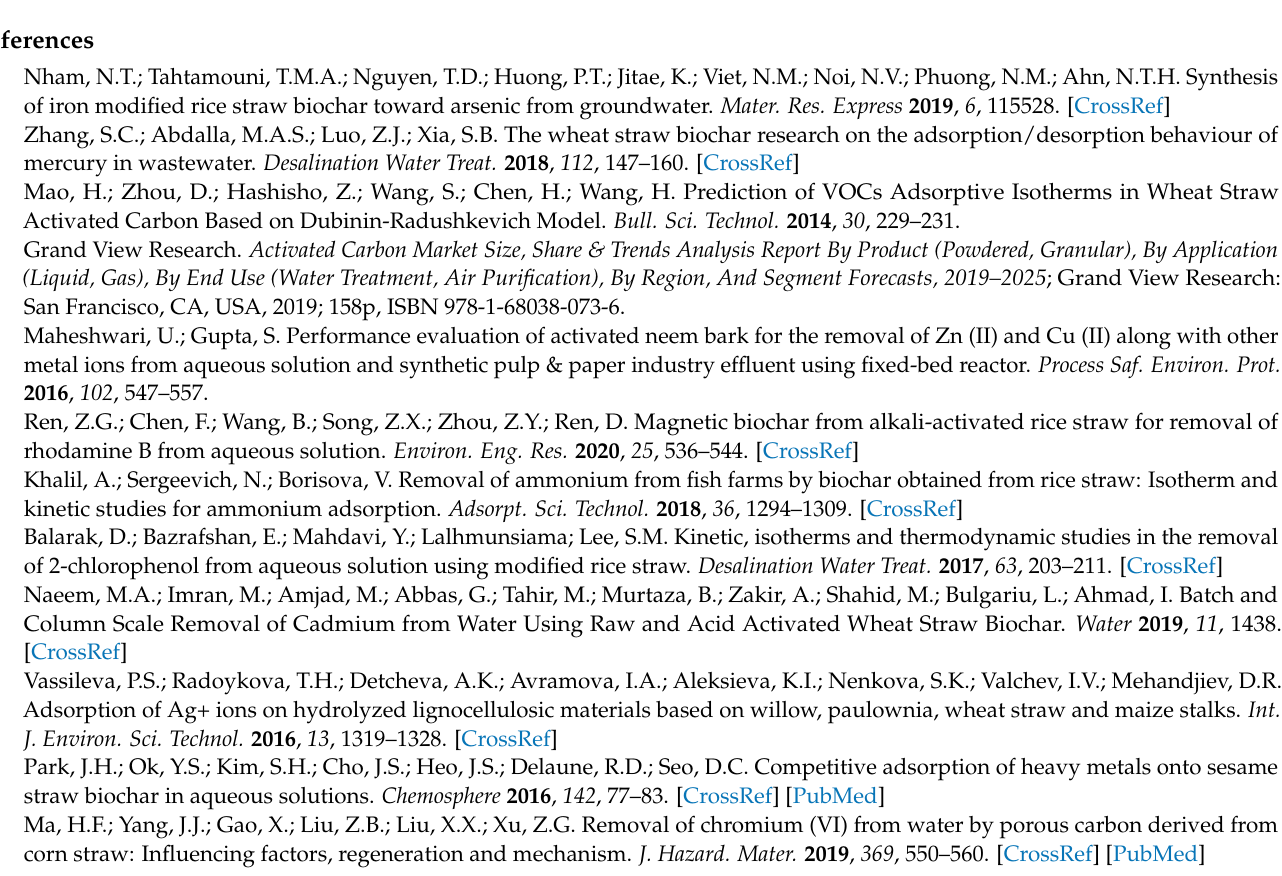
Table S2. Analysis of variance (ANOVA) of ethyl acetate adsorption capacity(Y2); Table S3. Analysis of variance (ANOVA) of yield(Y3); Figure S1: 3D surface of surface response plots for